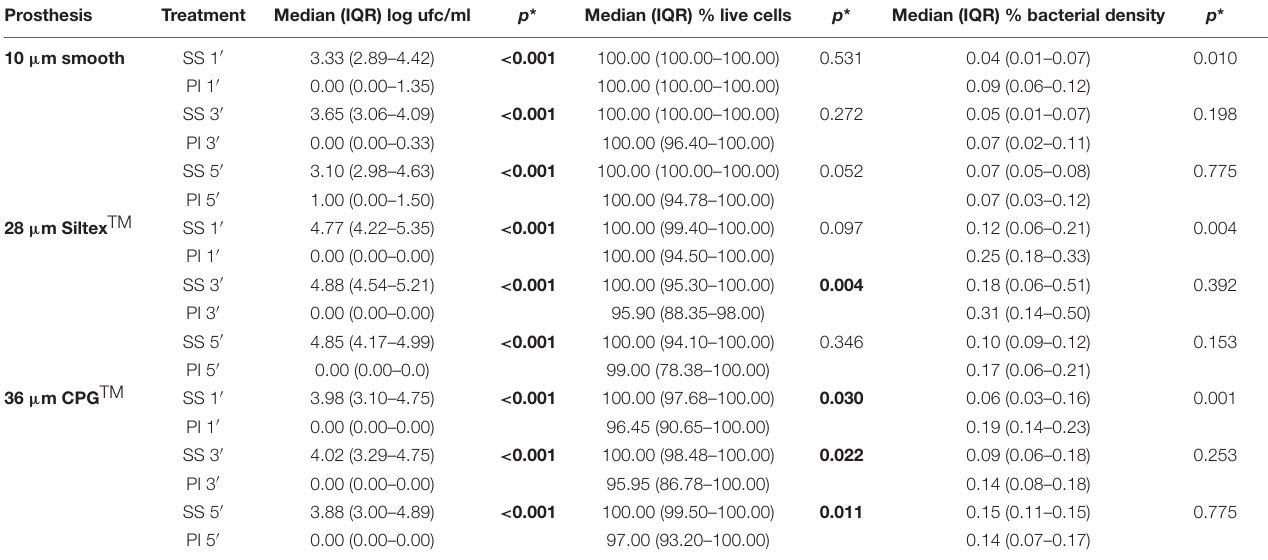
TABLE 1 | Results for povidone iodine at three times of exposure in Mentor R (cid:13) implants.